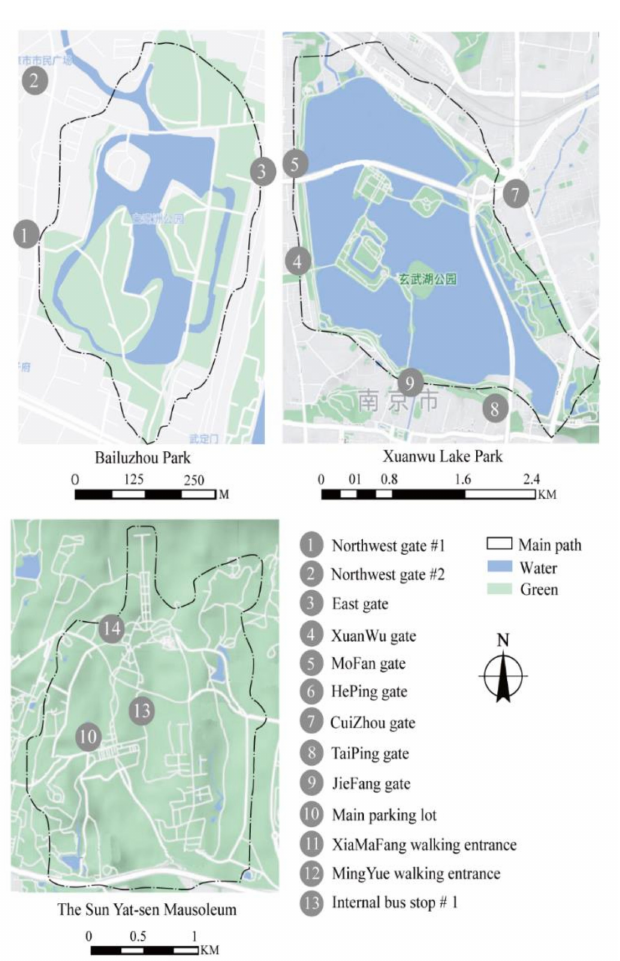
Figure A1. Topography of three parks. The base map is acquired from Google Maps. Copyright